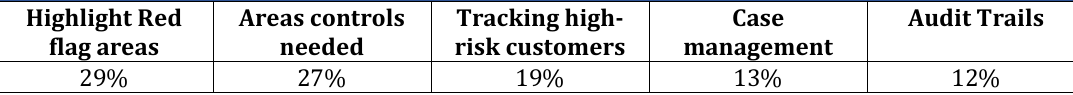
Table 14: Response about the Most Important Areas which are Crucial to an Anomaly Detection Solution Highlight